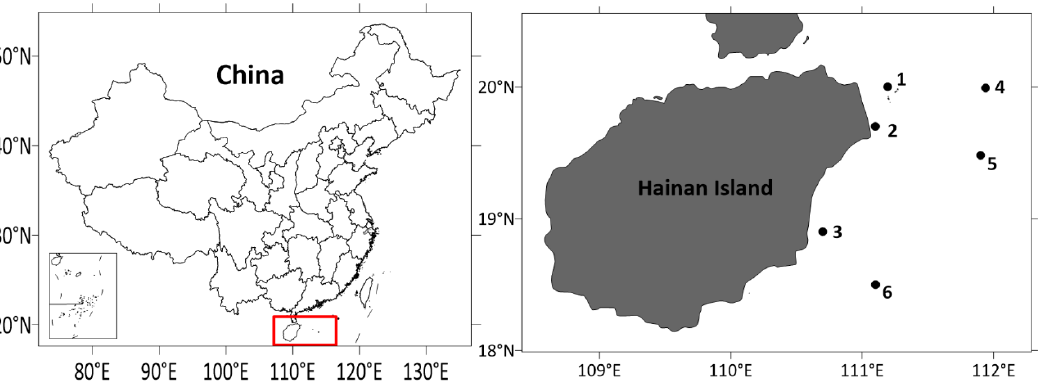
Figure 1. Map of sampling stations in the South China Sea. Stations 1, 2, and 3 represent inshore areas, and stations 4, 5, and 6 represent offshore areas. areas, and stations 4, 5, and 6 represent offshore